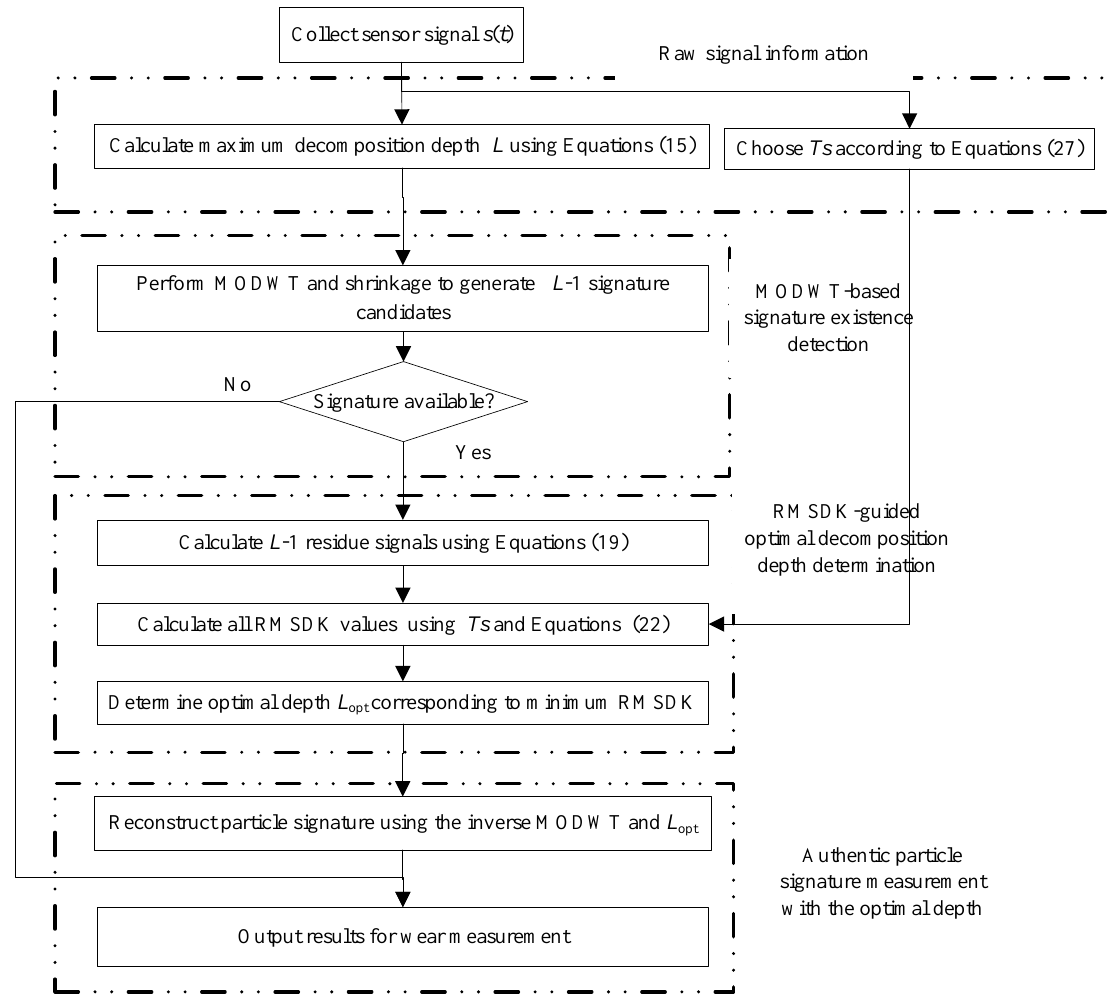
Figure 7. Flowchart of the proposed MODWT-ODD